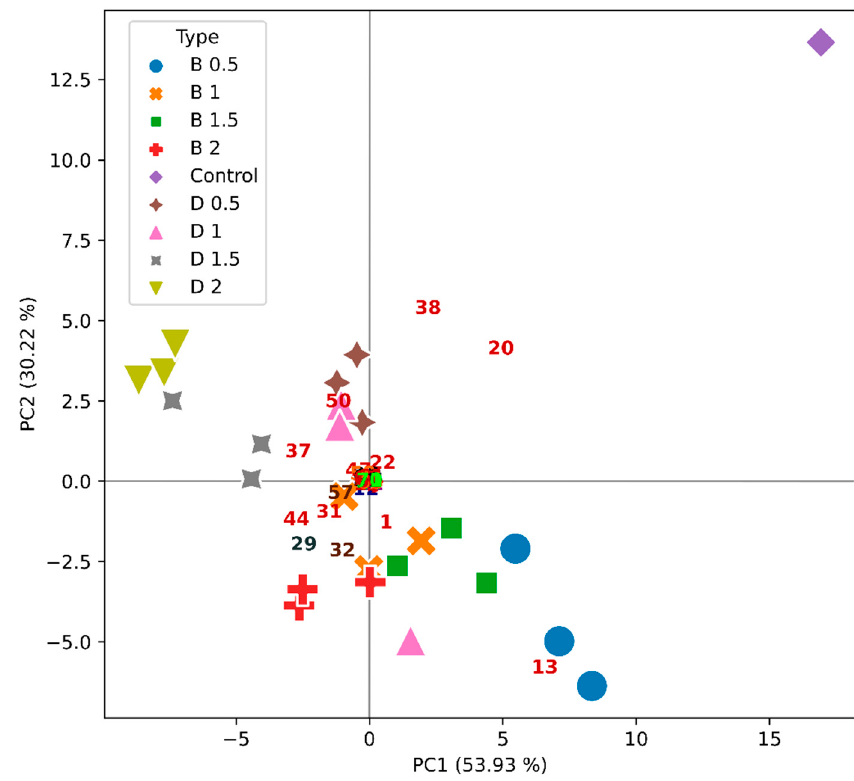
Figure 9. PCA illustrating the simultaneous projection of the wine samples (objects)—by a mark, and VOC (variables) loadings—by a number, for the Moscatel de Setúbal varietal wine. The different concentrations of bentonite (B) or DCMC (D) in g/L are indicated.